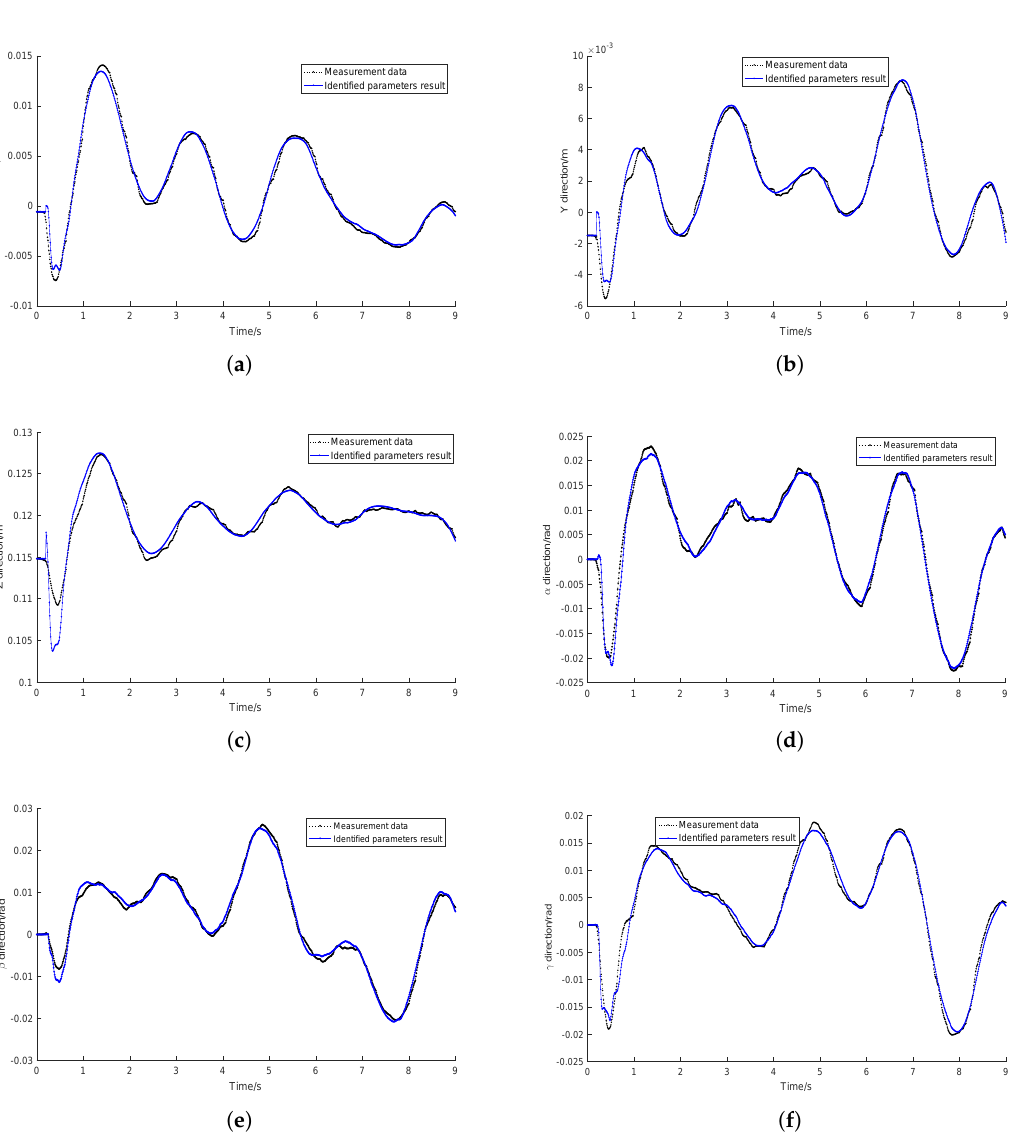
Figure 13. The pose trajectories of the parallel robot: the measurement of the real plant ( black dot ), the output of the simulation with identified parameters ( blue line ), ( a ) Along X Direction; ( b ) Along Y Direction; ( c ) Along Z Direction;( d ) Around α Axis; ( e ) Around β Axis; ( f ) Around γ